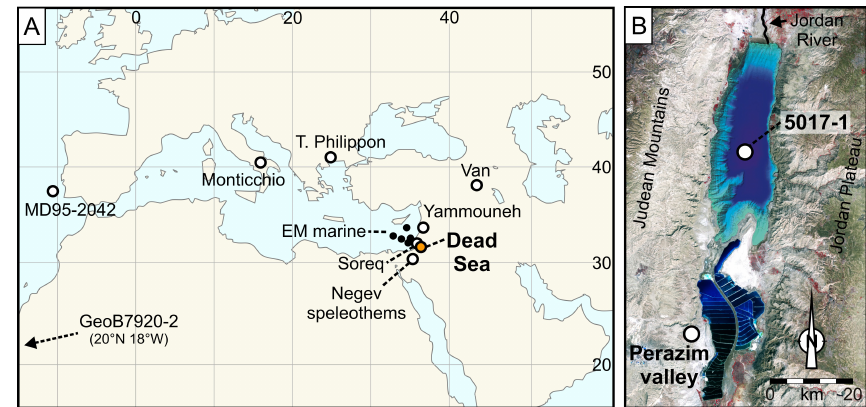
Figure 1. (a) Location of Mediterranean records discussed in the text; EM marine – eastern Mediterranean marine cores (Cheddadi and Rossignol-Strick, 1995; Almogi-Labin et al., 2009); Negev speleothems – various caves in the northern, central and southern Negev (Vaks et al., 2010); for references of the other records the reader is referred to the text. (b) Map of the Dead Sea (NASA image by R. Simmon using Landsat data, 2011, from USGS, www.visibleearth.nasa.gov/), with bathymetry of the northern Dead Sea basin from Sade et al. (2014), 5017-1 coring location, Perazim Valley Samra outcrop PZ-7 (Waldmann et al.,